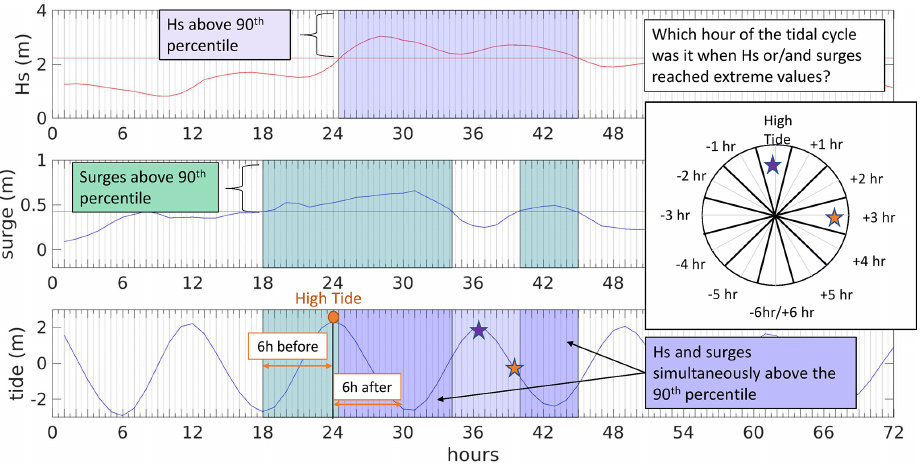
Figure 2. Schematic example explaining the methodology used to evaluate the number of extreme H s and surges with respect to the tidal cycle. This example shows 3d of the time series at one coastal point. The H s values higher than the 90th percentile (calculated over 3 months of data at the same point) are considered high. The closest tidal peak to each value is found. We then evaluate when each value occurred in the tidal cycle, from 6h before to 6h after high tide. The same is done for surges and for cases in which H s and surges are simultaneously higher than the respective 90th percentile. The two stars indicate examples where the extreme H s occurred at high tide and 3h after high tide.